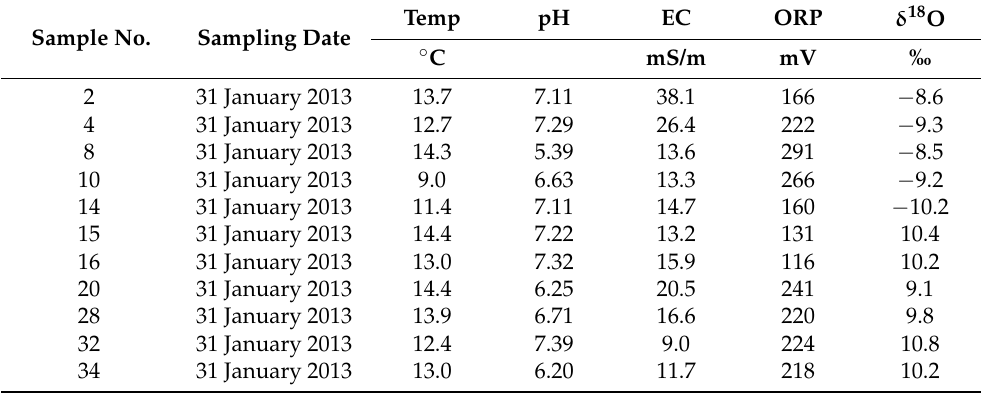
Table 11. Water temperature, pH, electric conductivity (EC), oxidation–reduction potential (ORP), and δ 18 O composition for groundwater samples in the Sho River alluvial fan on 31 January 2013. Sample